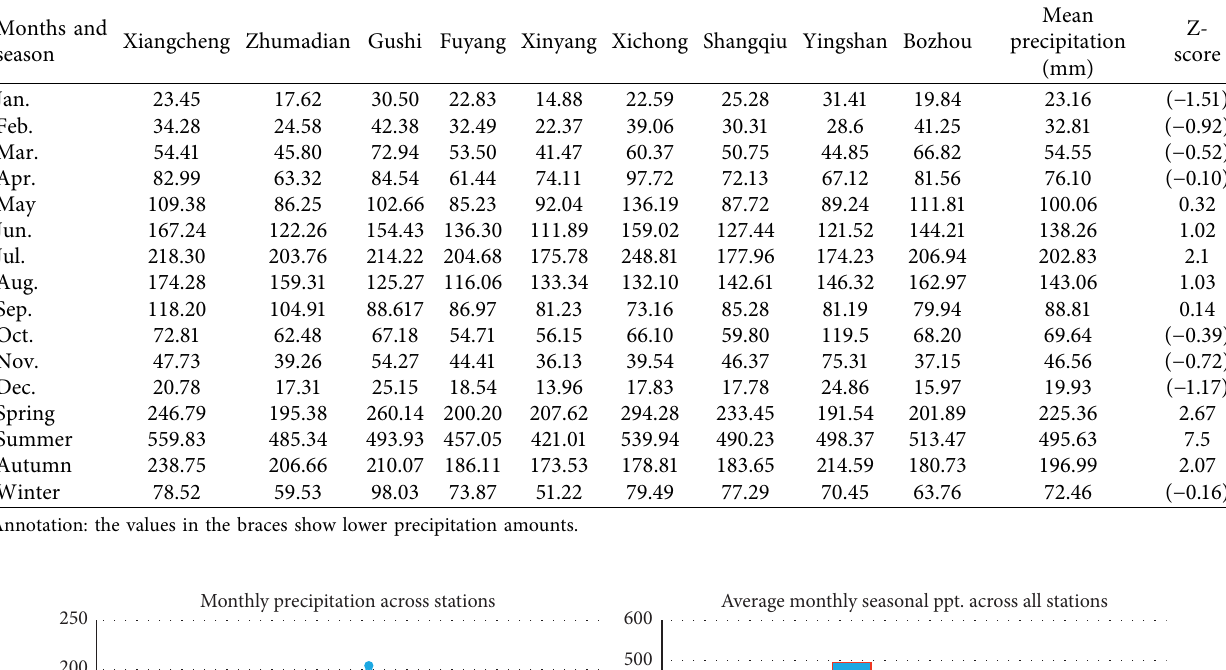
Table 2: Seasonal and monthly precipitation through the stations.